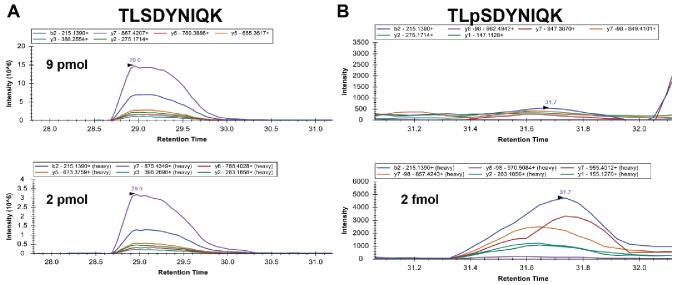
Analysis of stoichiometry of Ser57 phosphorylation of ubiquitin.Isotopically labeled (heavy) standard peptides corresponding to unmodified (bottom left) or Ser57 phosphorylated (bottom right) ubiquitin were spiked into ubiquitin affinity purified from ppz mutant yeast cells and multiple reaction monitoring analysis was performed. The top panels show the corresponding signal from the biological samples. Inset legends indicate plots for specific transitions. Based on transition peak areas, we calculate 9 pmol of the unmodified peptide in the biological sample. The phosphopeptide in the biological sample is below our limit of quantification but occurs at significantly less than 2 fmol.